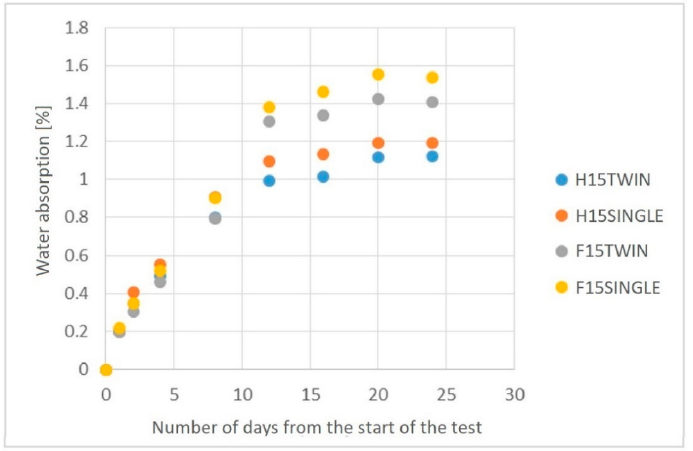
Figure 11. The water absorption of PHBV biocomposites produced by single- and twin-screw extrusion. Measurements of the fiber geometry on the surface layer of the compacts in Figure 12a,c indicate much longer fibers (for the single-screw method) compared to far fewer visible fibers on the surface of samples obtained from biocomposites produced on a twin-screw extruder (Figure 12b,d). The sample results of fiber geometry measurements, along with statistical analysis, are presented in Table 9.